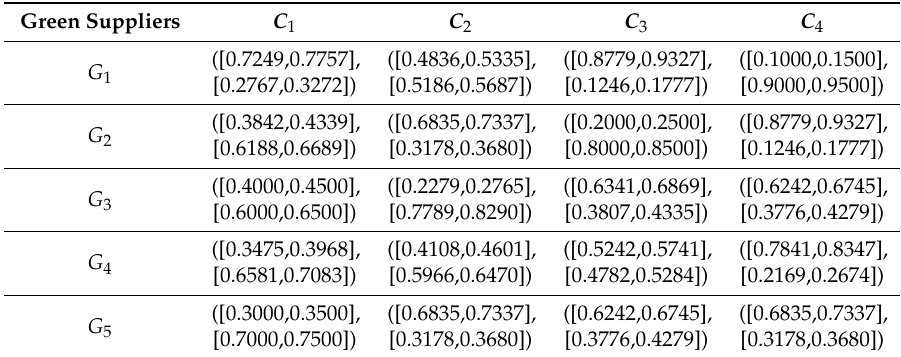
Table 5. Subgroup evaluation matrix R 3